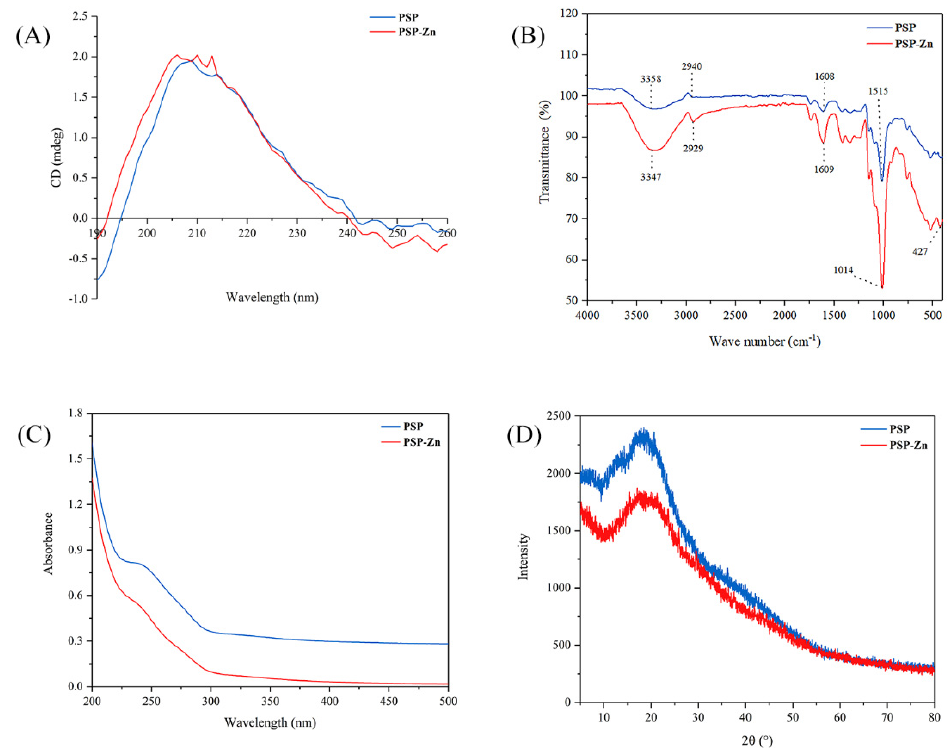
Figure 1. ( A ) CD spectrogram, ( B ) FT-IR spectrogram, ( C ) UV–visible spectroscopy, and ( D ) XRD patterns of PSP and PSP − Zn.